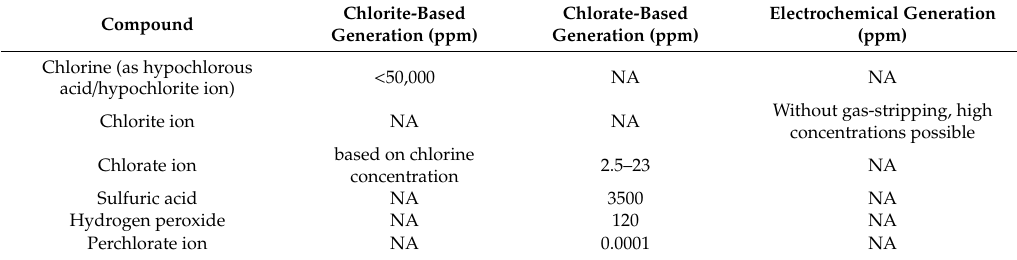
NA = generally not